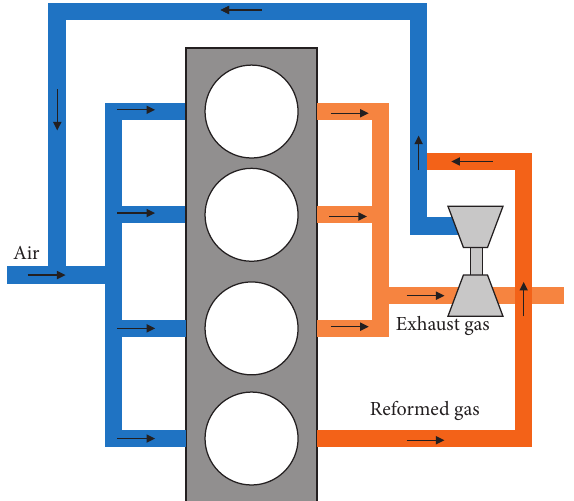
Figure 1: Schematics representation of the fuel reforming system in an HCCI